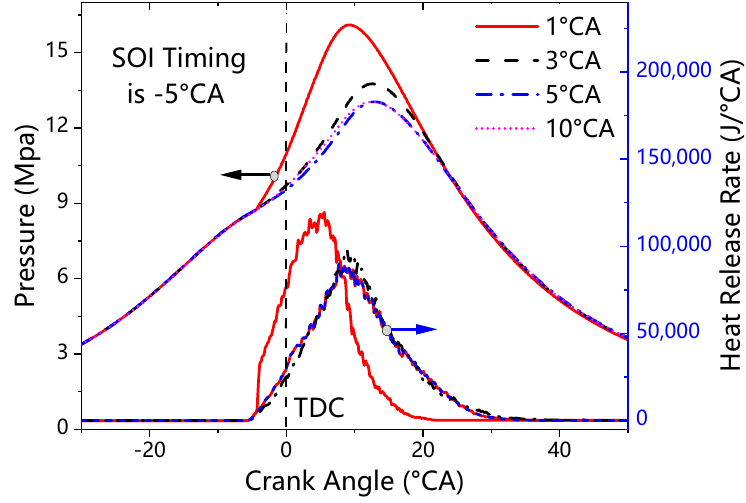
Figure 20. Mean pressure and rate of heat release at different pilot injection durations.